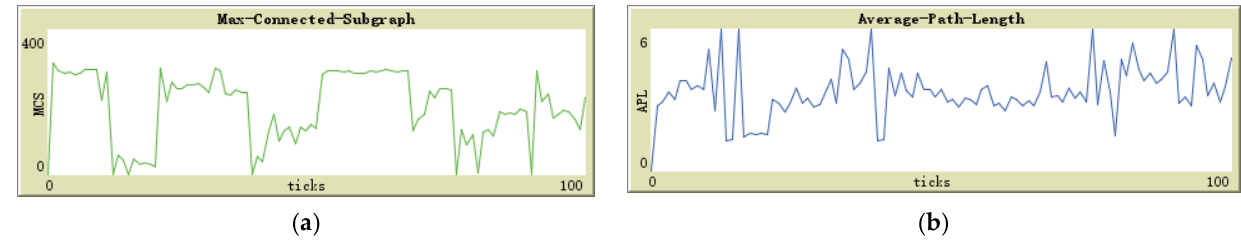
Figure 11. ( a ) MCS trend with air jammer; ( b ) APL trend with air jammer.